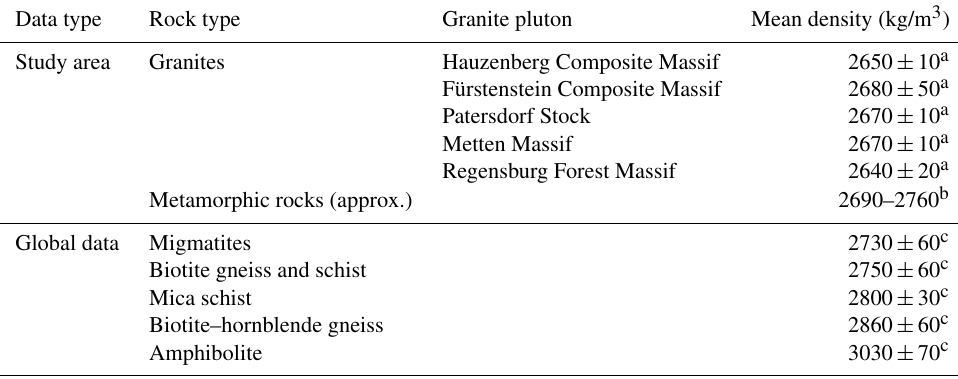
Table 3. Mean densities of granites and metamorphic rocks in the study area. Equivalent data on metamorphic rocks outside the study area are